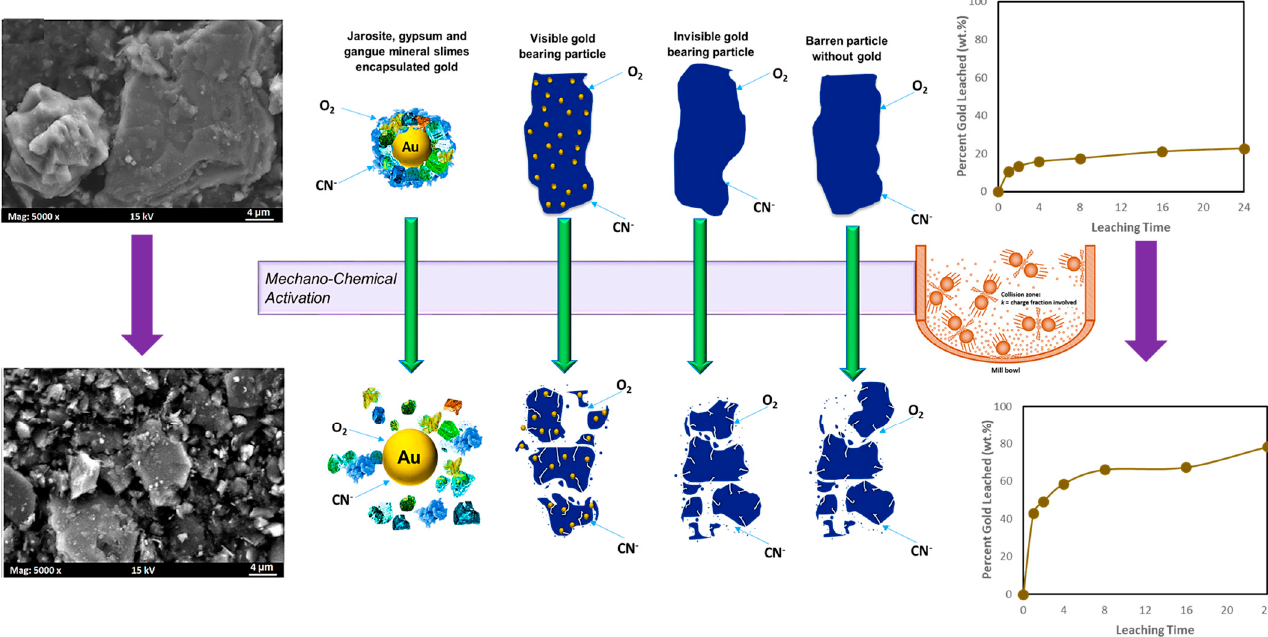
Figure 7. Schematic diagram showing the effect of mechano-chemical activation on the refractory bio-oxidation product and gold extraction performance, Modified after Asamoah et al. 2018 [18].